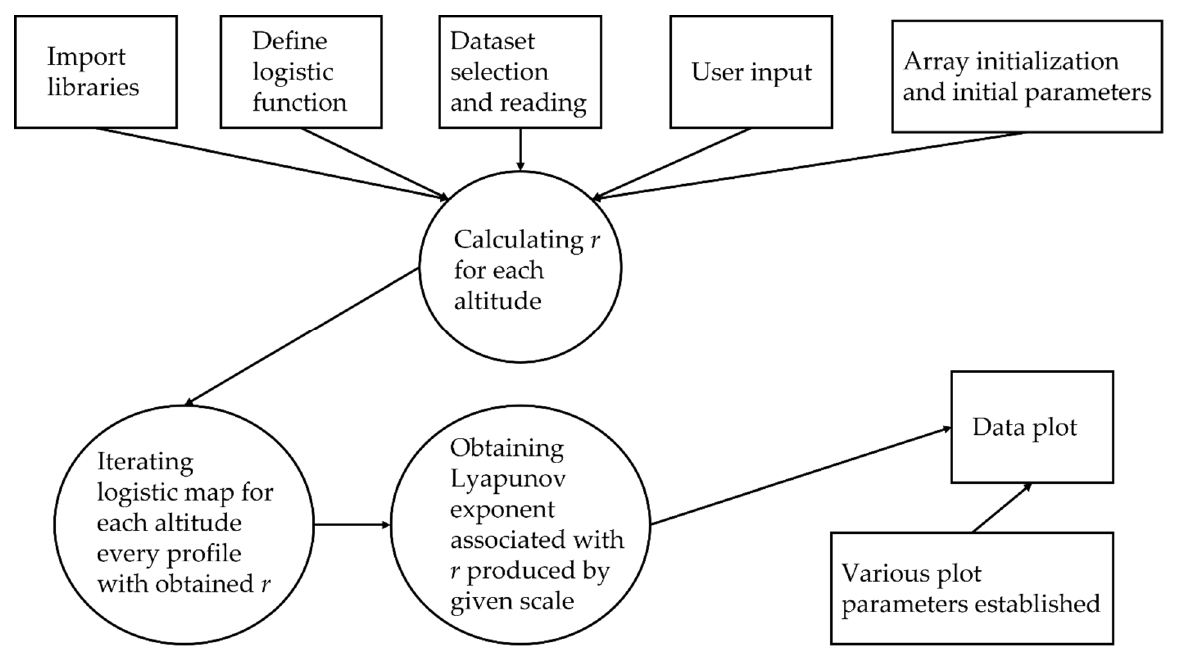
Figure 35. Algorithm workflow.